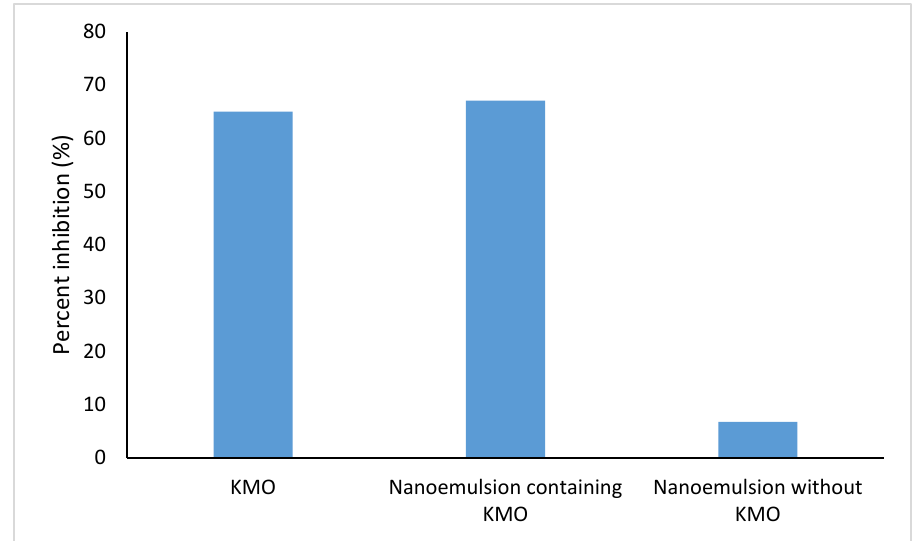
Figure 10. Inhibitory activity of tyrosinase enzyme at 20,000 µg/mL.